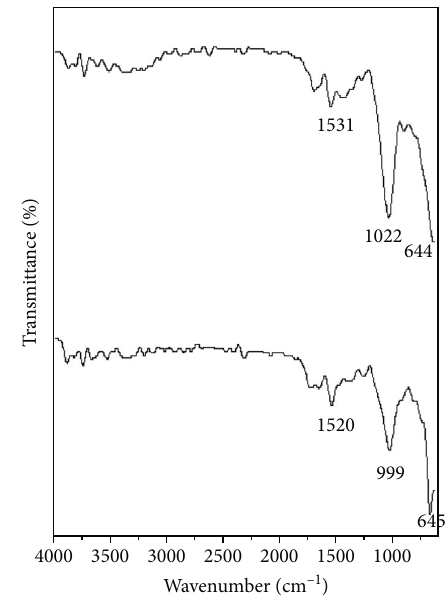
Figure 1: FTIR spectra of modi fi ed and unmodi fi ed garlic